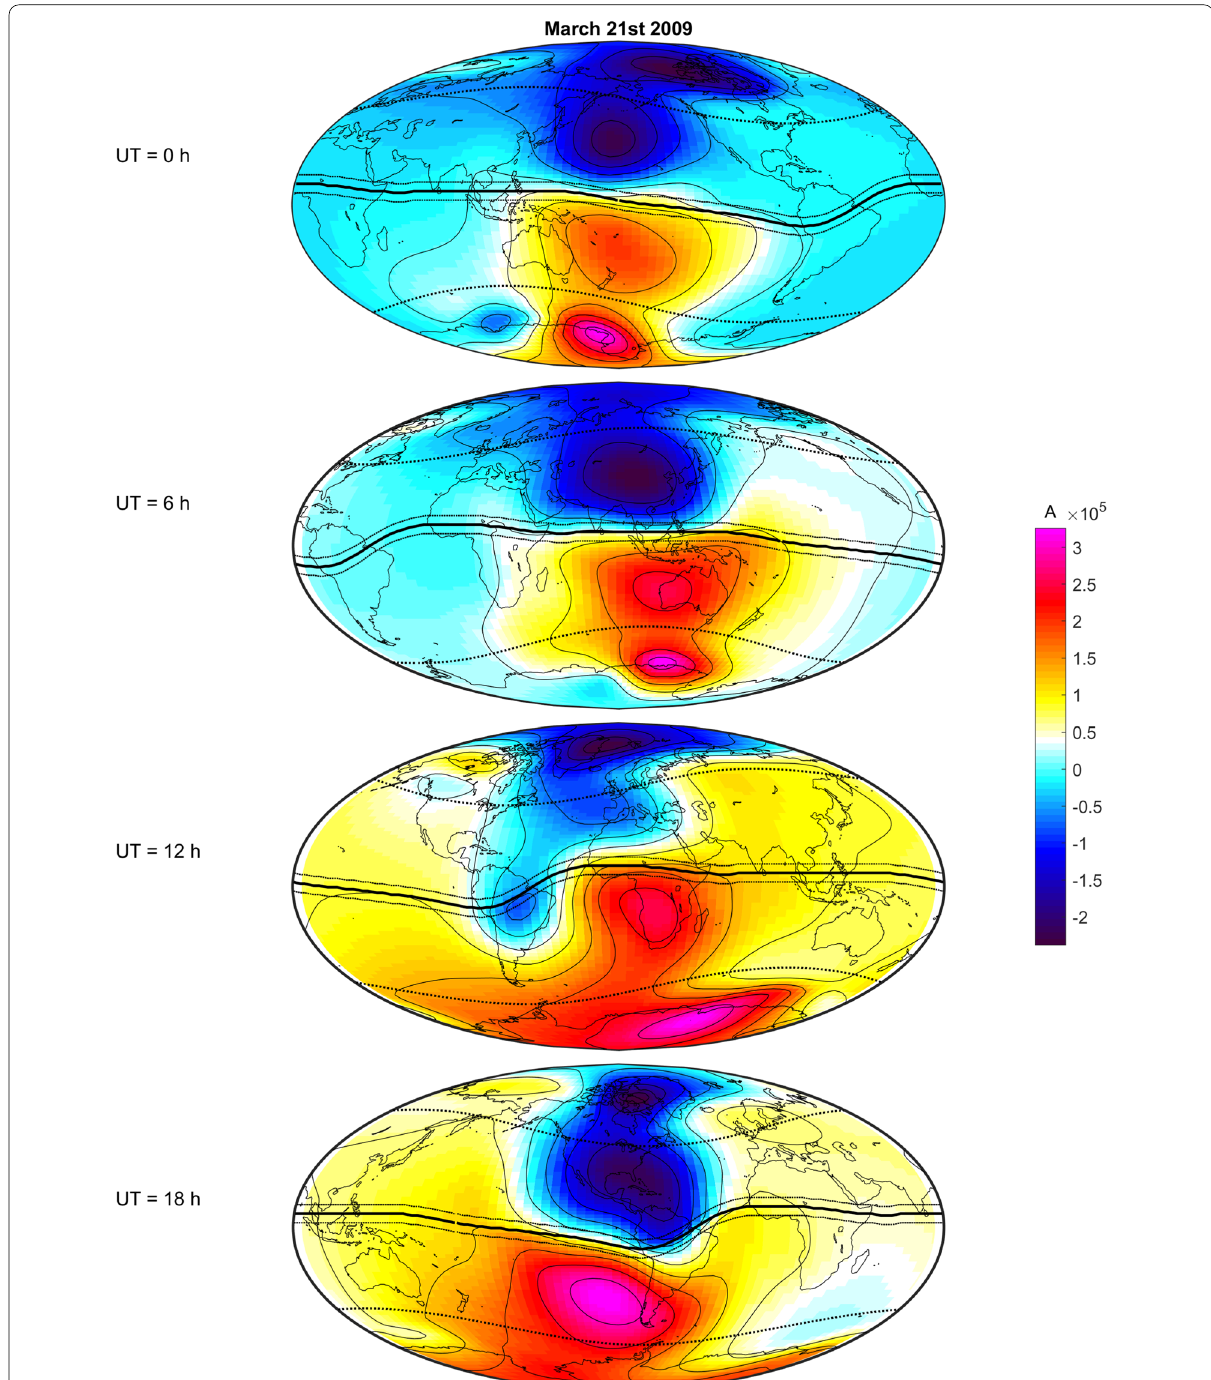
Fig. 1 Time snapshots of TIE-GCM stream function �( t ) on March 21 2009